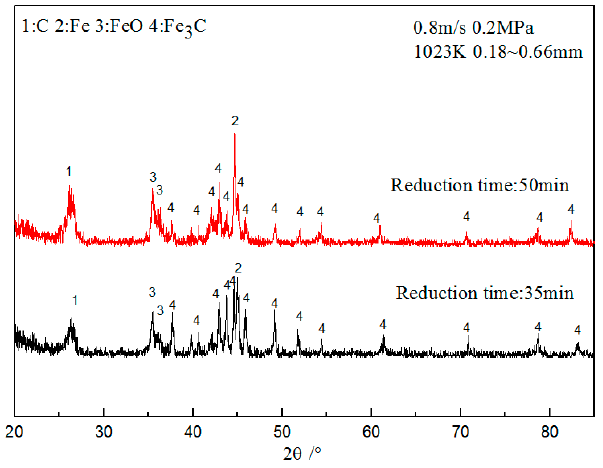
Figure 9. The X-ray diffraction spectrogram when 0.18 mm–0.66 mm of OMC fine iron ore is reduced by pure carbon monoxide at 0.2 MPa, 1023 K, 0.8 m/s after 35 min and 50 min.